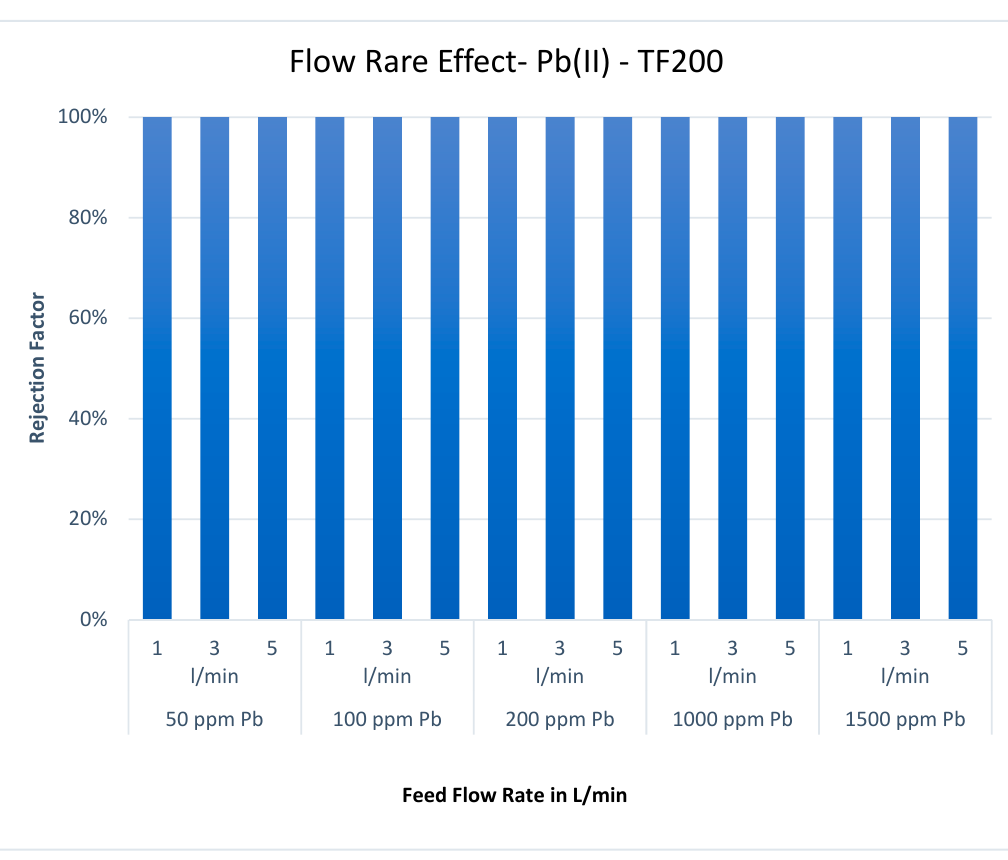
Figure 3. Effect of feed flow rate on the rejection factor using the TF200 membrane for Pb(II) (feed temperature = 50 °C, condensing temperature = 10 °C).